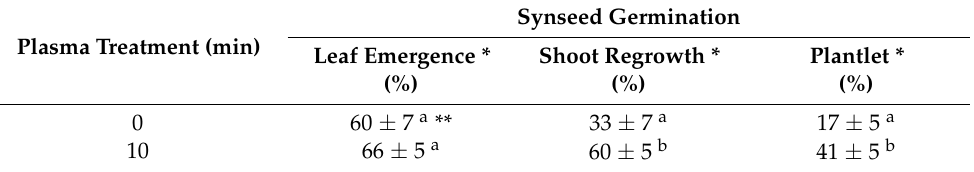
Table 3. The effect of plasma treatment on germination of chrysanthemum synseeds grown ex vitro.